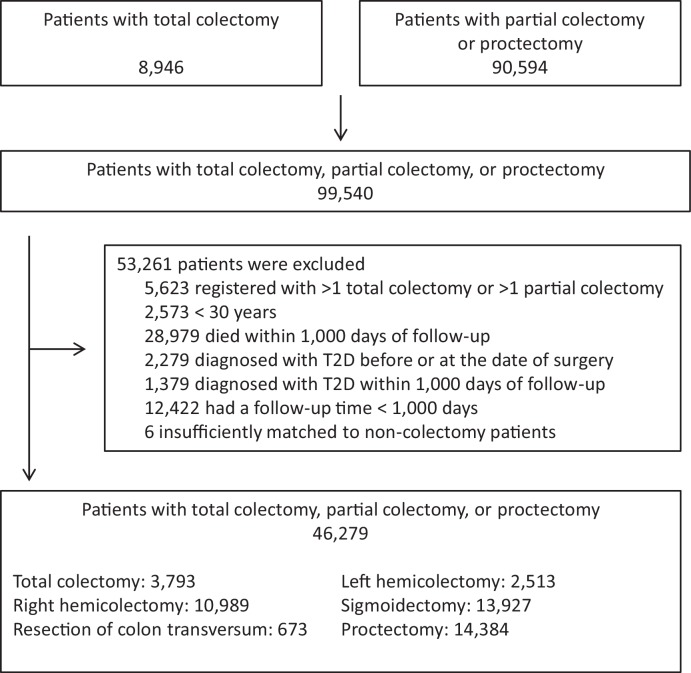
Study design.The chart illustrates the number of eligible patients, number of patients excluded and reasons for exclusions, and the final number of patients included. For each colectomy patient, 15 non-colectomy patients were selected among (1) patients who had undergone orthopedic surgery, (2) patients who had undergone abdominal surgery leaving the gastrointestinal tract intact, and (3) patients who had undergone other surgery, unrelated to the gastrointestinal tract. Five non-colectomy patients were selected from each surgery group resulting in inclusion of a total of 694,110 non-colectomy patients matched on age, sex, and year of surgery. Non-colectomy patients were selected using sampling with replacement wherefore the total number of matches are slightly lower than the total number of colectomy patients times 15. Total colectomy includes colectomy and proctocolectomy. T2D: clinically recorded type 2 diabetes.